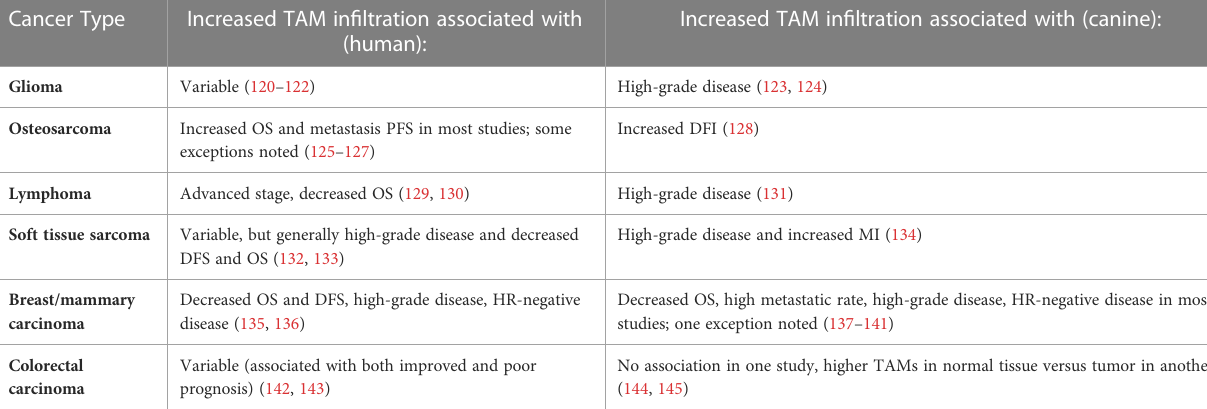
TABLE 2 Prognostic impact of tumor-associated macrophages in select human and canine cancers. Cancer